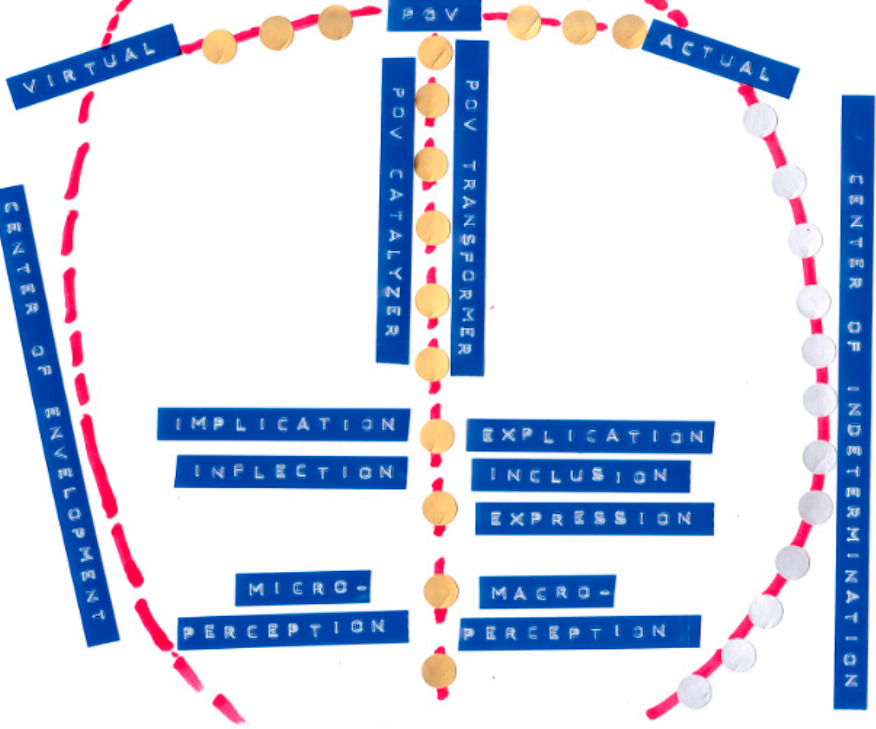
Figure 3. Center of envelopment and center of implication between POV-catalyzer and POV transformer.